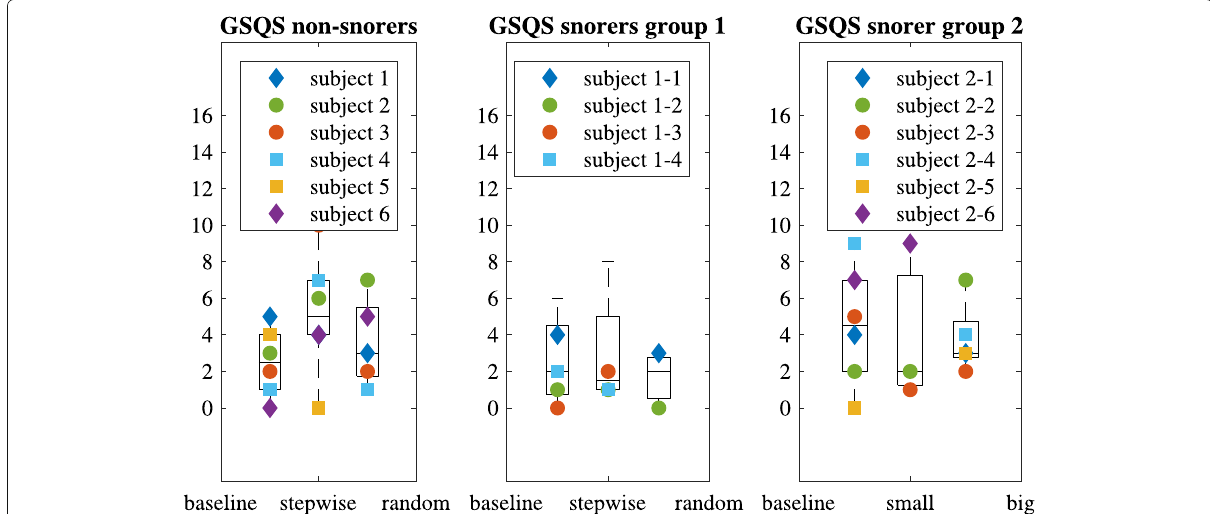
Fig. 4 Influence on subjective sleep quality. GSQS scores reach from 0 to 14 with 0 indicating good sleep and 14 indicating bad sleep. As depicted non-snorers slept worse during intervention nights. In group snorerone sleep quality improved slightly during the random angle condition. The group snorertwo had a tendency to report better sleep quality in both intervention conditions. None of these results was